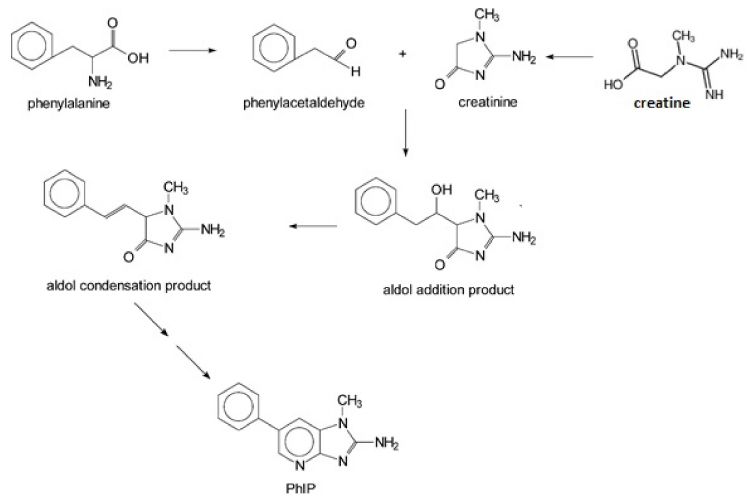
Figure 1. PhIP chemical formation